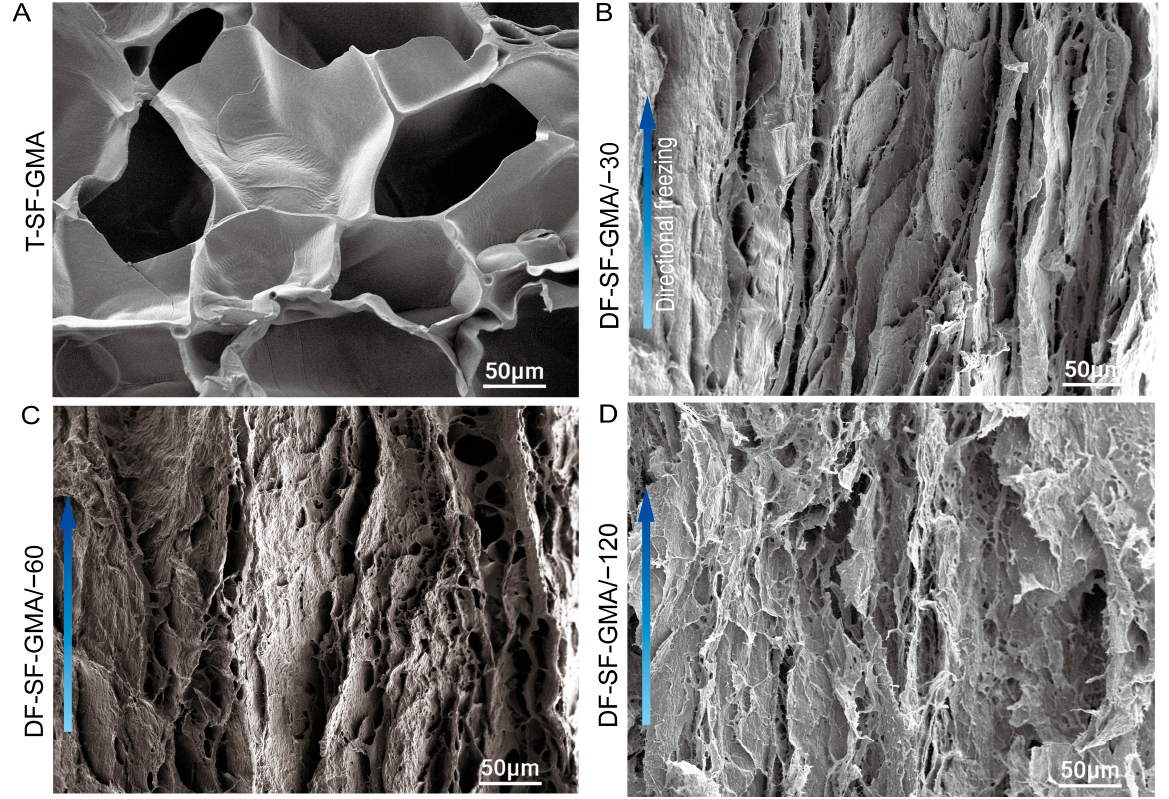
Figure 3. Characterization of the aligned porous structures of the DF-SF-GMA hydrogels. Scanning electron microscopy (SEM) images of the vertical section of the traditional hydrogel (T-SF-GMA) ( A ) and the hydrogels fabricated by directional freezing at − 30 °C (DF-SF-GMA/ − 30) ( B ), − 60 °C (DF-SF-GMA/ − 60) ( C ), and − 120 °C (DF-SF-GMA/ − 120) ( D ). The porous structures in the T-SF-GMA hydrogel are induced by ice particles randomly formed during freezing. The SF molecules in the DF-SF-GMA hydrogels are excluded from the ice and aggregate between the aligned ice crystals and photo-crosslinked during melting. These aligned porous structures already exist prior to freeze drying.